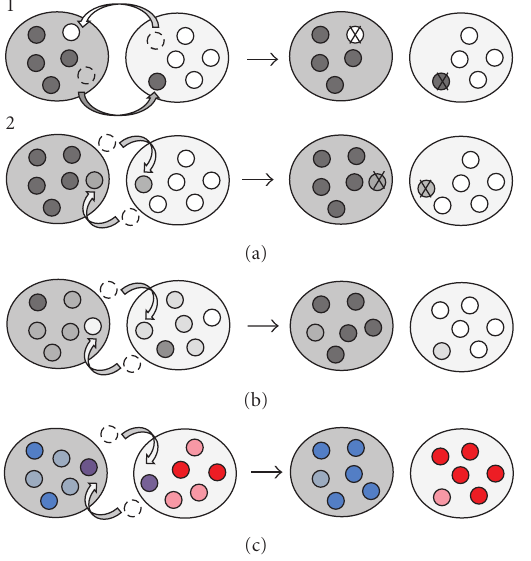
Figure 2: Schematic presentation of models of parasite-mediated speciation. (a) Reproductive isolation due to reduced viability or fecundity of immigrants and hybrids . (1) Immigrants from host populations (a) (dark grey) and (b) (light grey) su ff er higher infection levels in the habitat of the other population resulting in reduced survival or fecundity. (2) Hybrids (middle grey) between divergently adapted parent populations (a) and (b) have higher infection levels and reduced survival or fecundity in either of the parental habitats as their intermediate defence profiles cannot match with the parasite pressure of the parental habitats. (b) Reproductive isolation due to pleiotropic e ff ects of MHC on mate choice . Divergence of parasite infections between host populations (indicated by darker and lighter grey background) with initially similar MHC profiles leads to divergent adaptation in MHC profiles to the particular infection conditions (dark grey and light grey). Reproductive isolation between the populations increases in the course of the process through the pleiotropic e ff ects of MHC on mate choice. (c) Ecologically based sexual selection . Two host populations that di ff er in parasite infections because of habitat or diet, diverge in their use of mating cues because di ff erent cues better signal heritable resistance to the di ff erent infections (here red and blue). Initially they are weakly reproductively isolated with frequent occurrence of hybrid individuals (purple). Sexual selection for individuals that better resist parasites in a given environment (bright blue and red) over more heavily infected individuals (pale blue and red) facilitates divergent adaptation and results in reproductive isolation between the